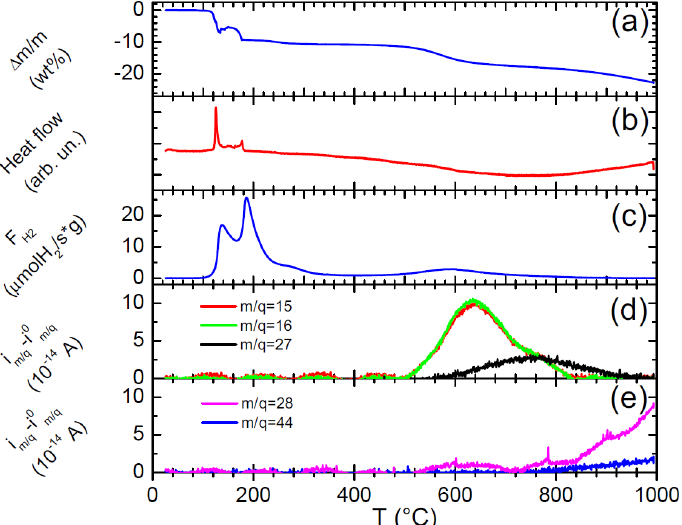
Figure 2. Differential thermal analysis-thermal gravimetric analysis-Mass spectrometry (DTA-TGA-MS) curves of ethane 1,2-diamineborane (EDAB) obtained under flowing Ar conditions at a heating rate of 2 K·min − 1 . ( a ) Relative mass loss ( ∆ m/m ) calculated from the TGA signal. ( b ) Heat flow recorded by the DTA apparatus. ( c ) Hydrogen desorbed flow ( F H2 ) obtained from the i 2 mass spectrometric signal. ( d ) Mass spectrometric ionic currents ( i m/q − i m/q 0 , where i m/q 0 are the corresponding baselines) at m / q = 15, 16 and 27 ascribed to CH 4 and C 2 H 4 desorption. ( e ) Mass spectrometric ionic currents at m / q = 28 and 44 ascribed to CO and CO 2 desorption.